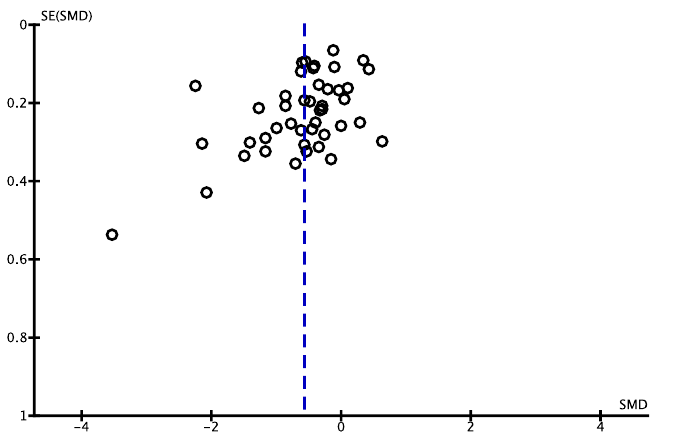
Figure 4. Funnel plot for mean weight change comparing web-based interventions with offline control groups ( n = 44). Each circle represents a study, and the vertical dashed line represents the pooled effect size. In the absence of a publication bias, the plot should look symmetric. SMD, standardized mean difference; SE, standard error.